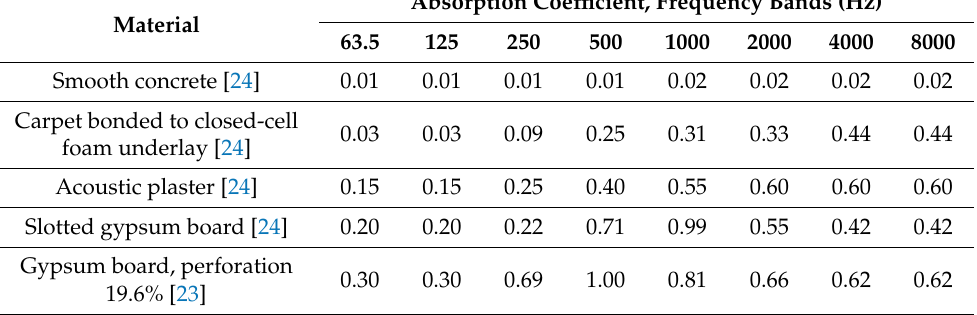
Table 5. Material setting of wall.